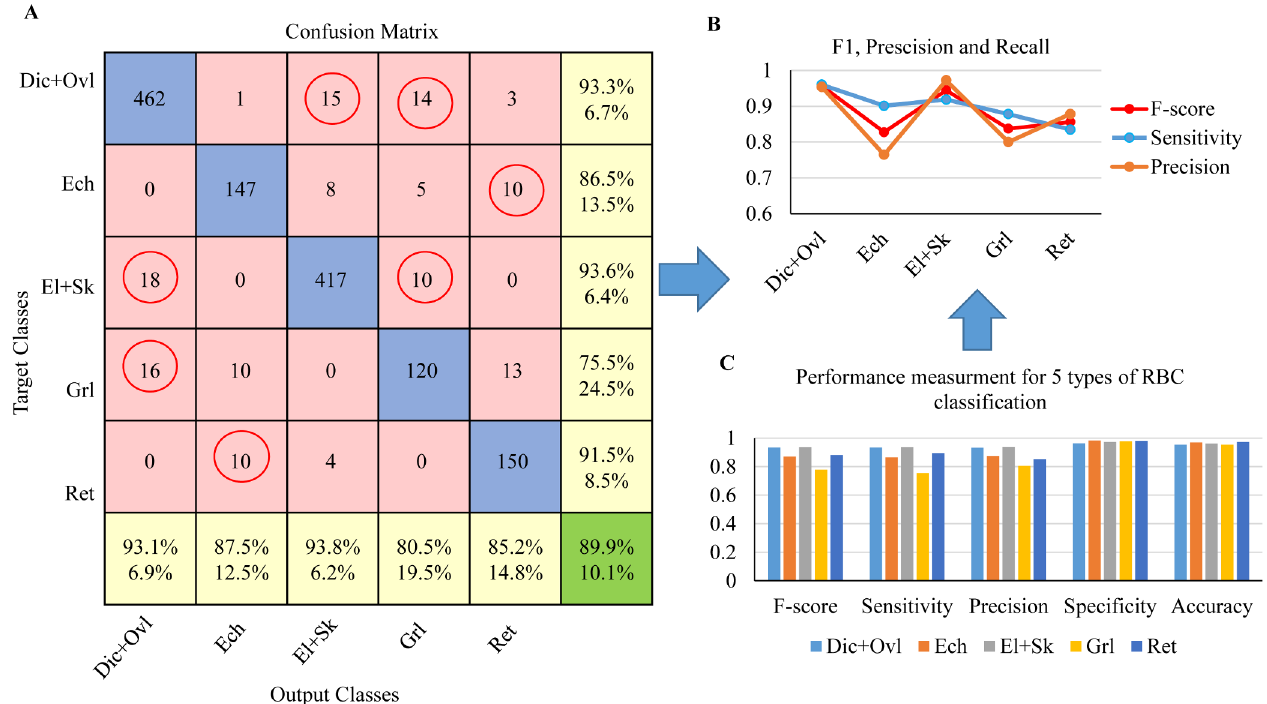
Fig 13. Performanceanalysis for SCD RBC classification based on “Exp_II” dataset (coarse labeling). (A) confusionmatrix showingthe detailednumber of correctly classifiedRBC images and misclassified RBC images, (B) 5 statistic metrics for the 5 types of RBC category prediction results, (C) Specific F-score, precisionand recall analysisfor different RBC categories.